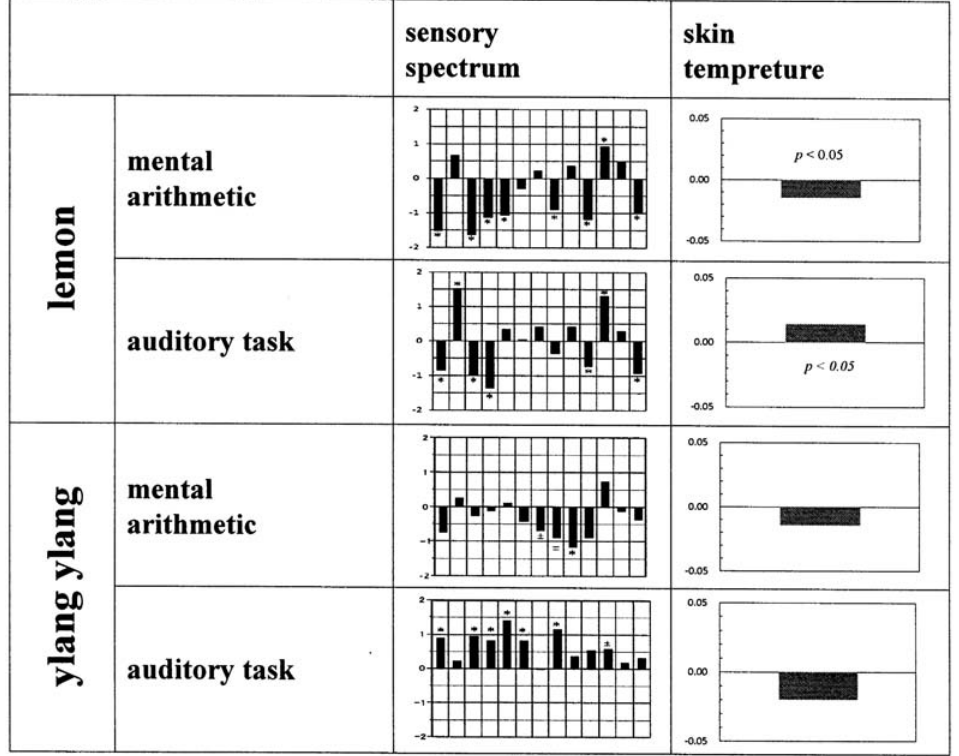
Figure 9. Summary of the verbal and non-verbal responses following inhalation of lemon and ylang ylang essential oils in terms of the sensory evaluation spectrum and skin temperature changes as a function of behavioural task. The number of subjects as for sensory profiling study was 43 for lemon/mental arithmetic, 41 for lemon/auditory task, 19 for ylang ylang/mental arithmetic and 24 for ylang ylang/auditory task. In regards to the number of subjects concerning skin temperature study, see Figures 7 and